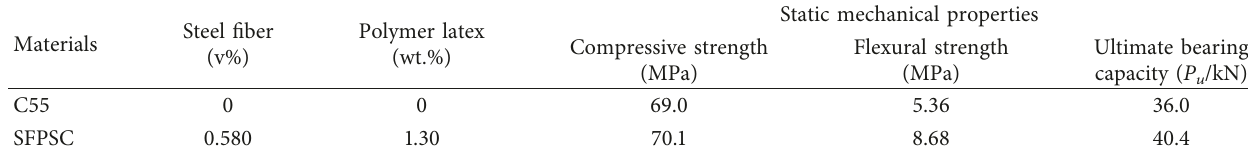
Table 1: Static mechanical properties of SFPSC and C55